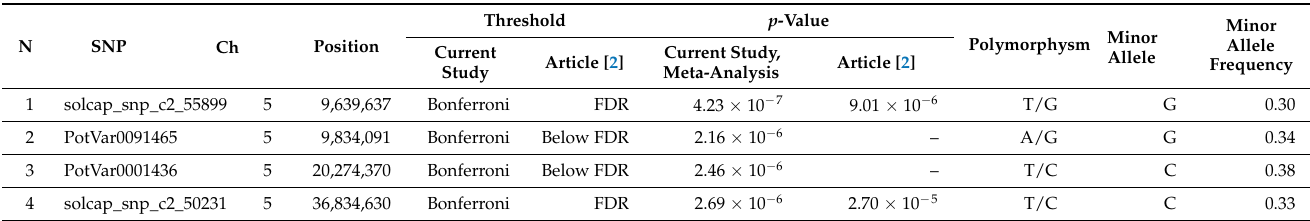
Table 5. Significant SNPs